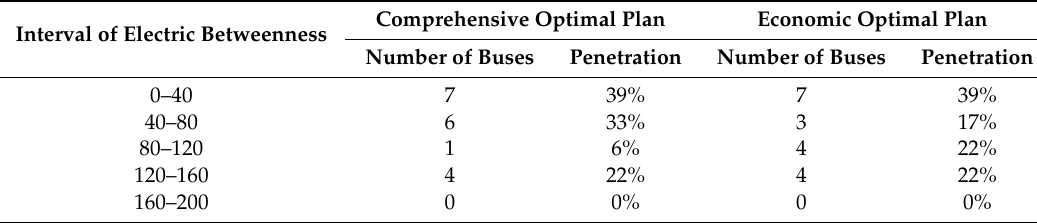
Table 6. Distribution of electric betweenness of